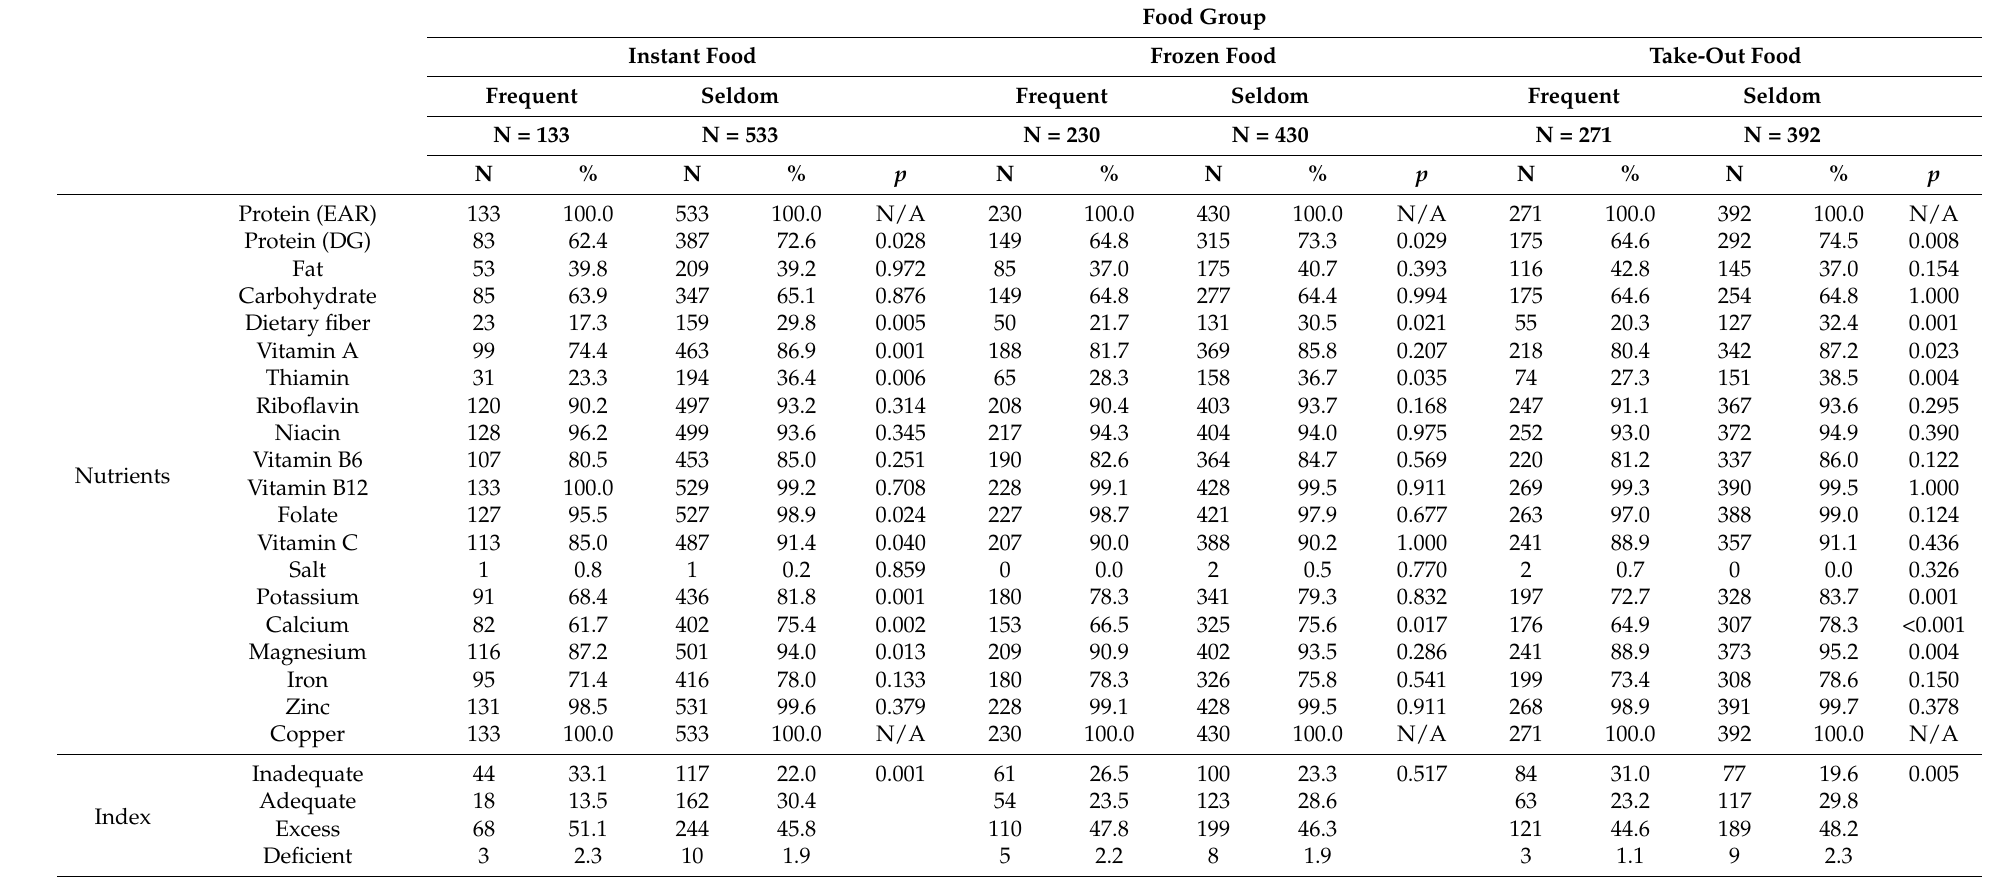
Table 4. Dietary reference index (DRI) comparison and dietary